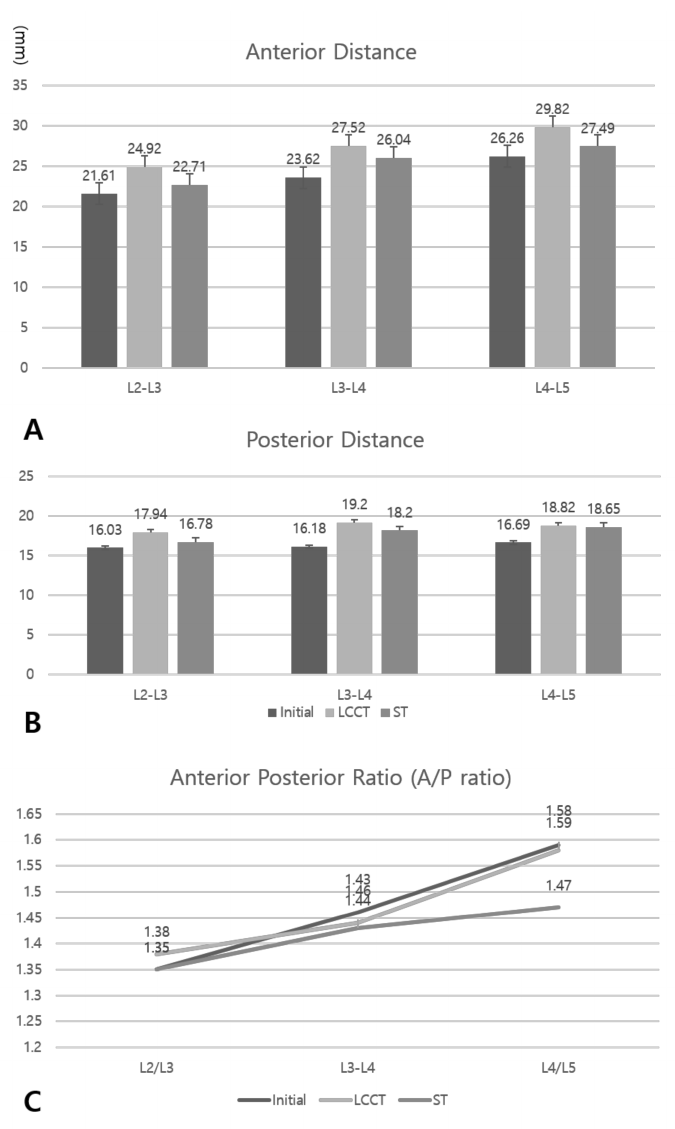
Figure 3. The intervertebral disc distances ( A ) in anterior and ( B ) posterior side in each vertebra. ( C ) The ratios of anterior and posterior distance in each vertebra. Abbreviation: initial indicates pre-operative position; LCCT, lordotic curve-controlled traction device; ST, standard